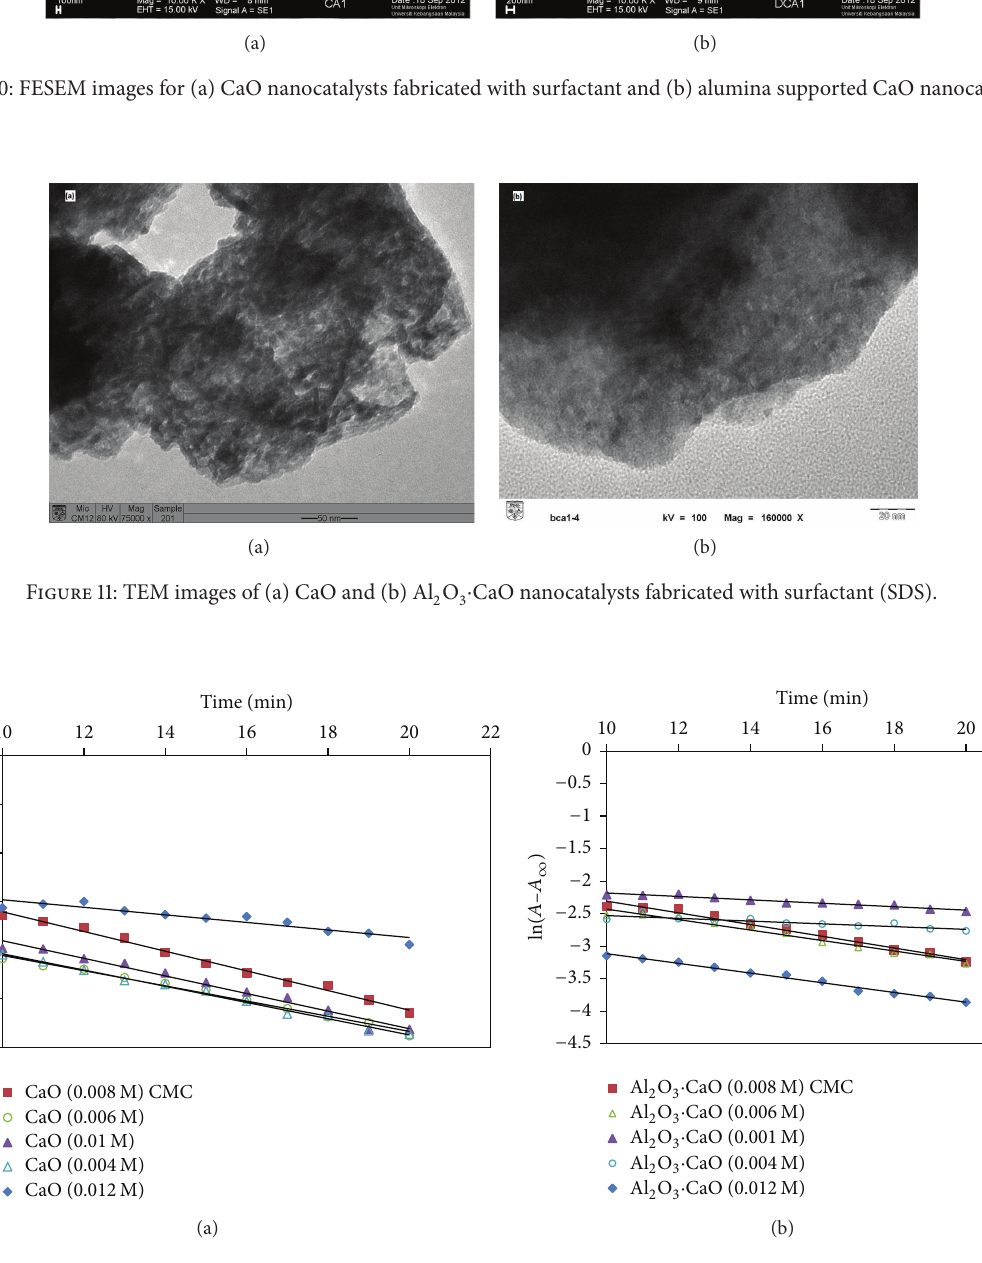
Figure 12: Plot of ln( 𝐴 – 𝐴 ∞ ) versus time for the oxidation of 2,4,6-TNP with (a) CaO and (b) Al 2 O 3 ⋅ CaO nanocatalysts prepared under different concentrations of